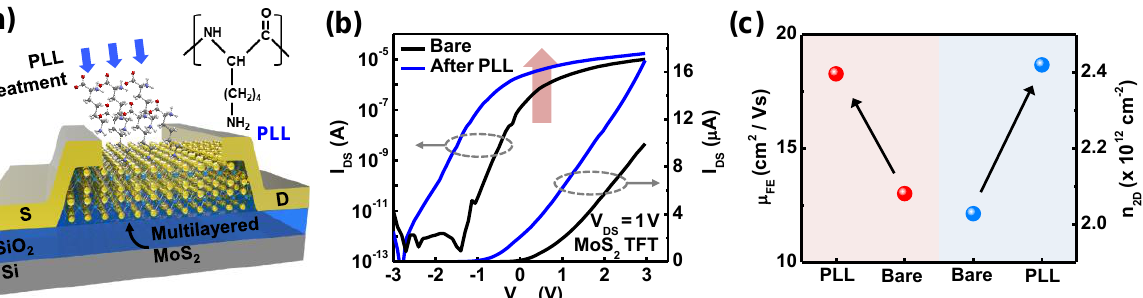
Figure 6. ( a ) A schematic illustration of m-MoS 2 TFTs with PLL molecules treated on the surface of m-MoS 2 ; ( b ) transfer characteristics of m-MoS 2 TFTs at V DS = 1 V before and after PLL treatment; ( c ) extracted field effect mobility and carrier concentration before and after PLL treatment.